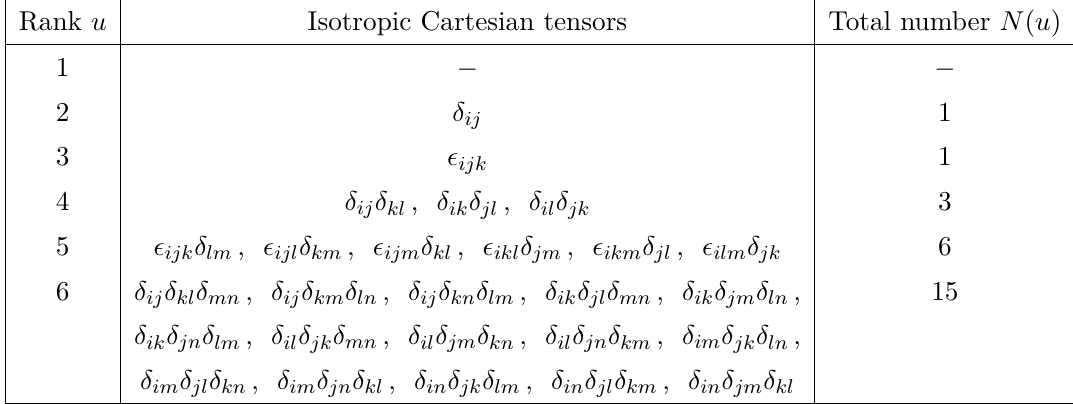
Table 2 . Distinct and independent isotropic Cartesian tensors up to rank 6 . The total number is calculated by using eq.